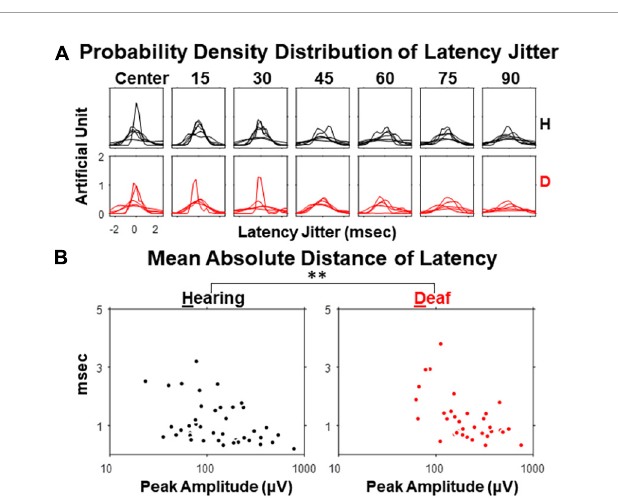
FIGURE7 Jitter of peak latency for VEP P1 component in hearing and early deaf cats. (A) The estimated probability density for each of 7 stimulus eccentricities. Each line represents one of the subjects in both groups. (B) Mean absolute deviation (MAD) of resampled latency plot against the peak amplitude of the averaged waveform. Left, hearing. Right, deaf. Each dot represents one stimulus eccentricity in one subject. ∗∗ p < 0.01 for the main effect of deafness in